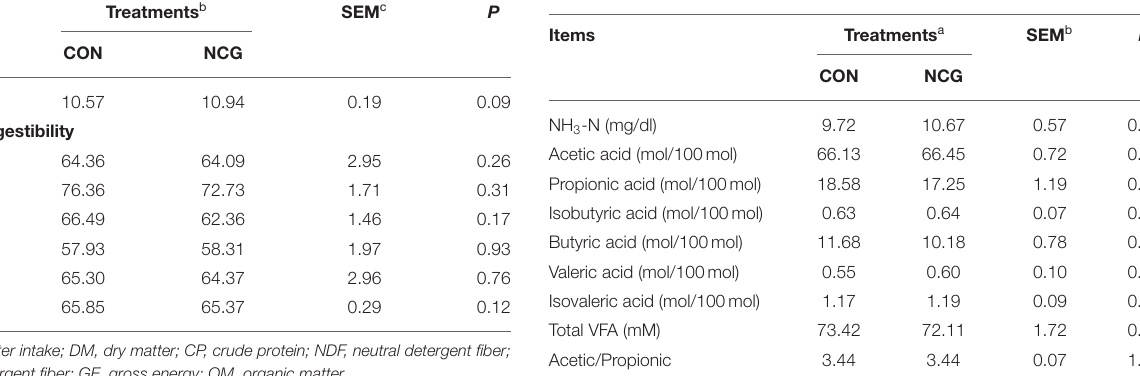
TABLE 4 | Effect of NCG on rumen fermentation parameters of experimental Jersey